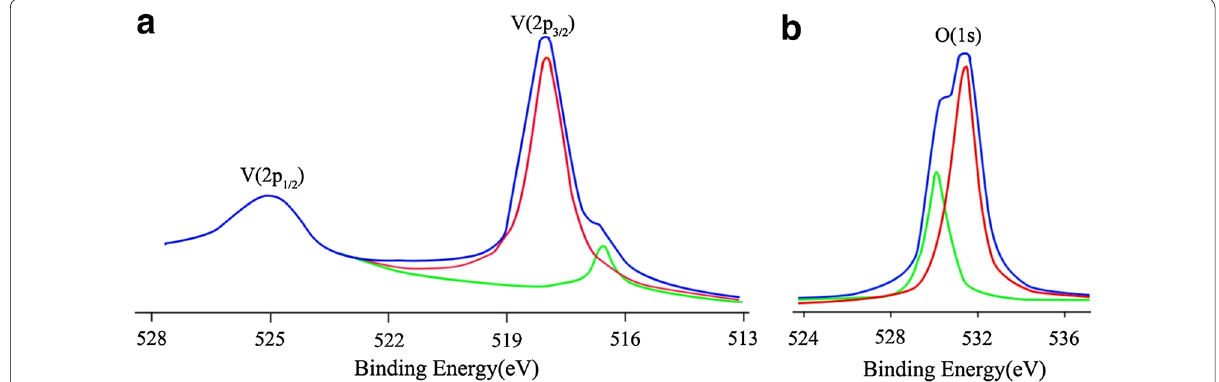
Fig. 4 V2p ( a ) and O1s ( b ) XPS spectra of the VAlPO 4